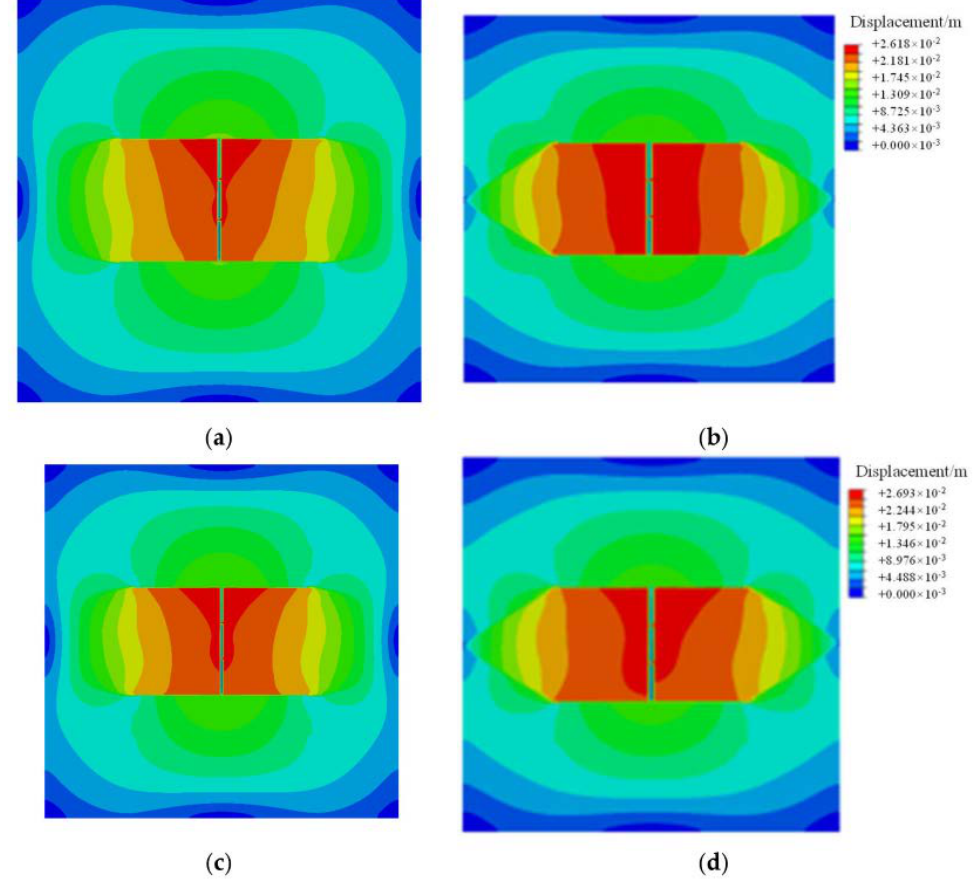
Figure 12. Cloud picture of displacement field under different bond strengths: ( a ) bond strength of 0.6 MPa (low electric resistivity) and time t = 55 s; ( b ) bond strength of 0.6 Mpa (low electric resistivity) and time t = 100 s; ( c ) bond strength of 3 Mpa (medium electric resistivity) and time t = 55 s; and ( d ) bond strength of 3 Mpa (medium electric resistivity) and time t = 100